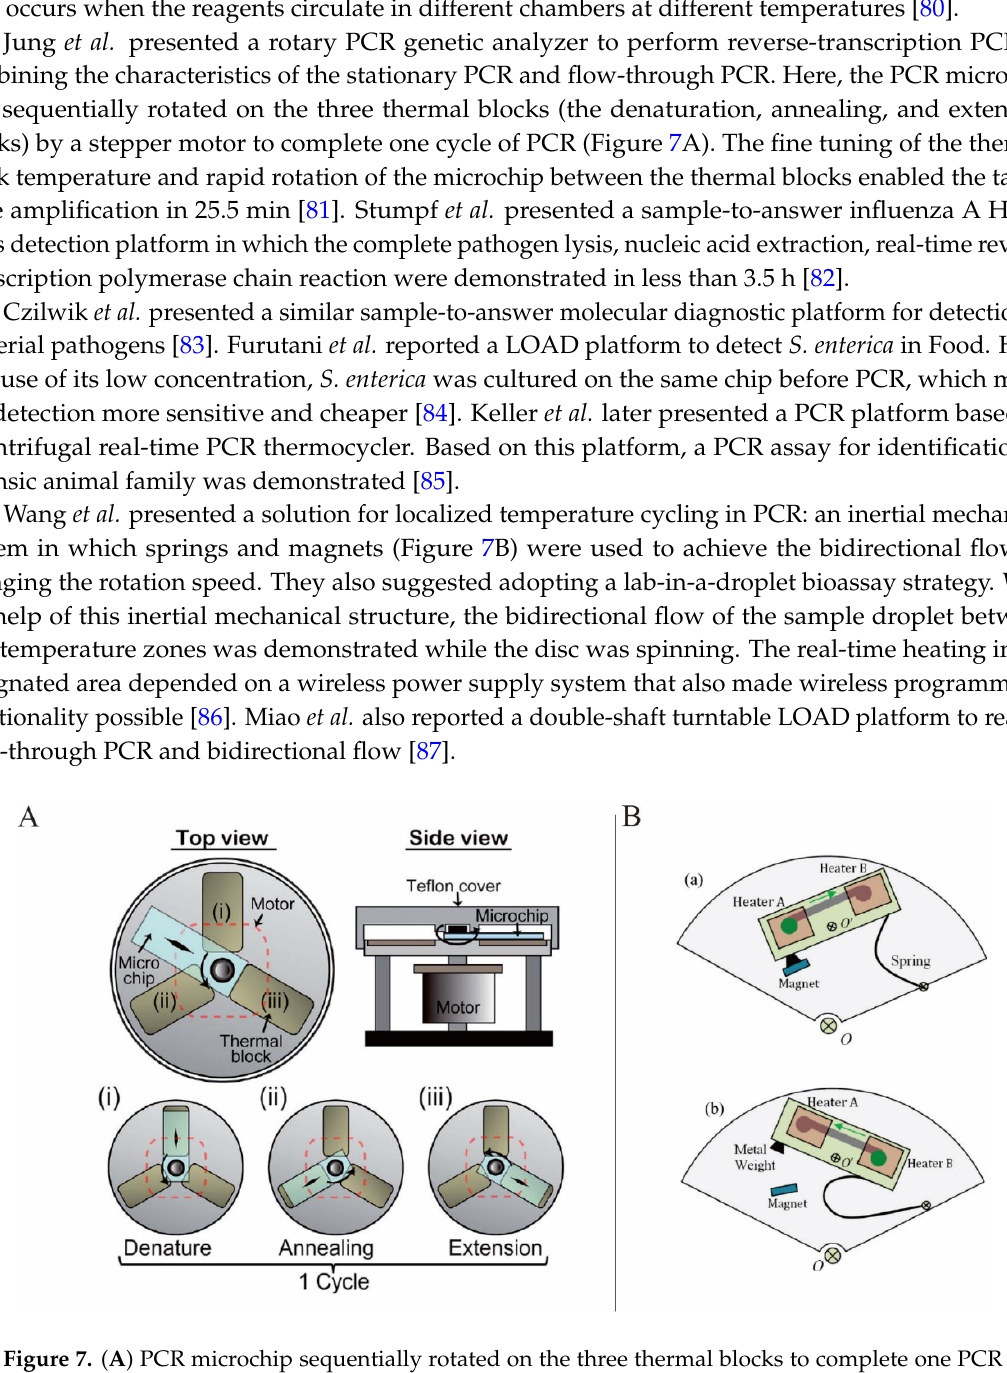
Figure 7. ( A ) PCR microchip sequentially rotated on the three thermal blocks to complete one PCR cycle. Figure reprinted with permission from [81]. ( B ) Speed actuated inertial mechanical structure: ( a ) low speed state, ( b ) high speed state. Figure reprinted with permission from [86].